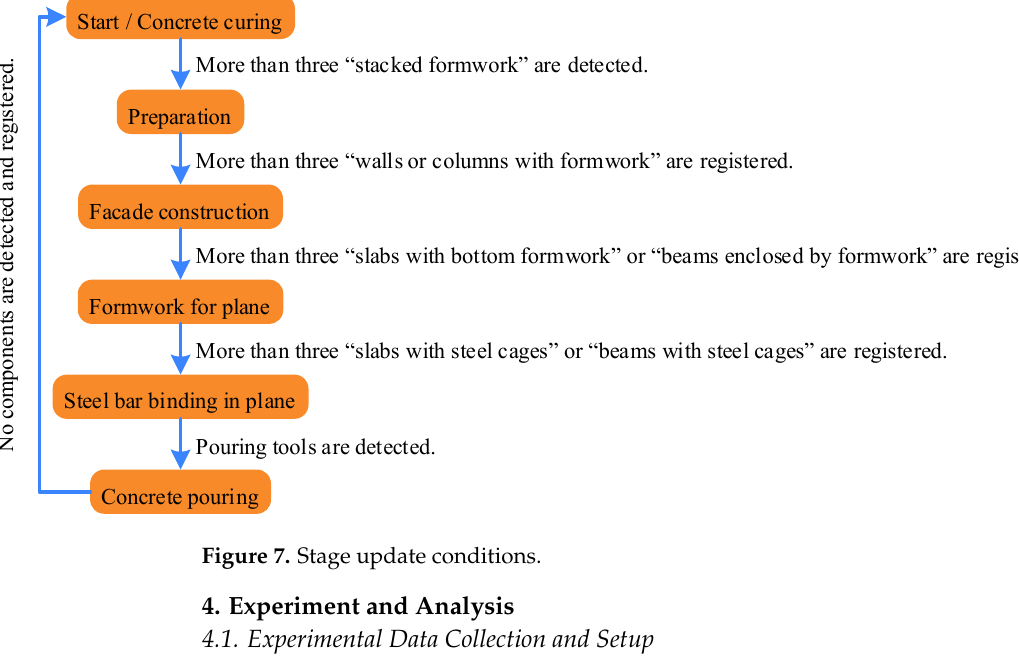
Figure 8. Image distribution. 4.2. Results and Analysis In the process of obtaining the construction schedule, three results are generated: de- tection result, registration result and process reasoning result. In the following, these re- sults are analyzed to evaluate the performance of the method. The collected image data belong to different floors and different construction stages, and the content of multiple images taken at the same time is repeated. To eliminate the influence of sample size, the images taken at the same time are regarded as a group (64 groups in total), and then these groups are classified into five construction stages. Therefore, taking the construction stage as the category and the group as the unit, these data were averaged and analyzed. The detection results are shown in Table 3, including the detection accuracy of vari- ous components and the time-consuming of each image. In the calculation, the repeated components in the same group are treated as a component as it only needs to be identified once to prove that the component already exists.